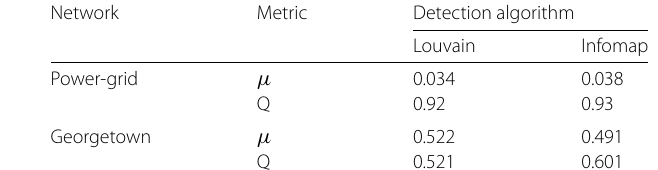
Table 5 The estimated mixing parameter μ and the modularity Q in Power-grid and Georgetown networks